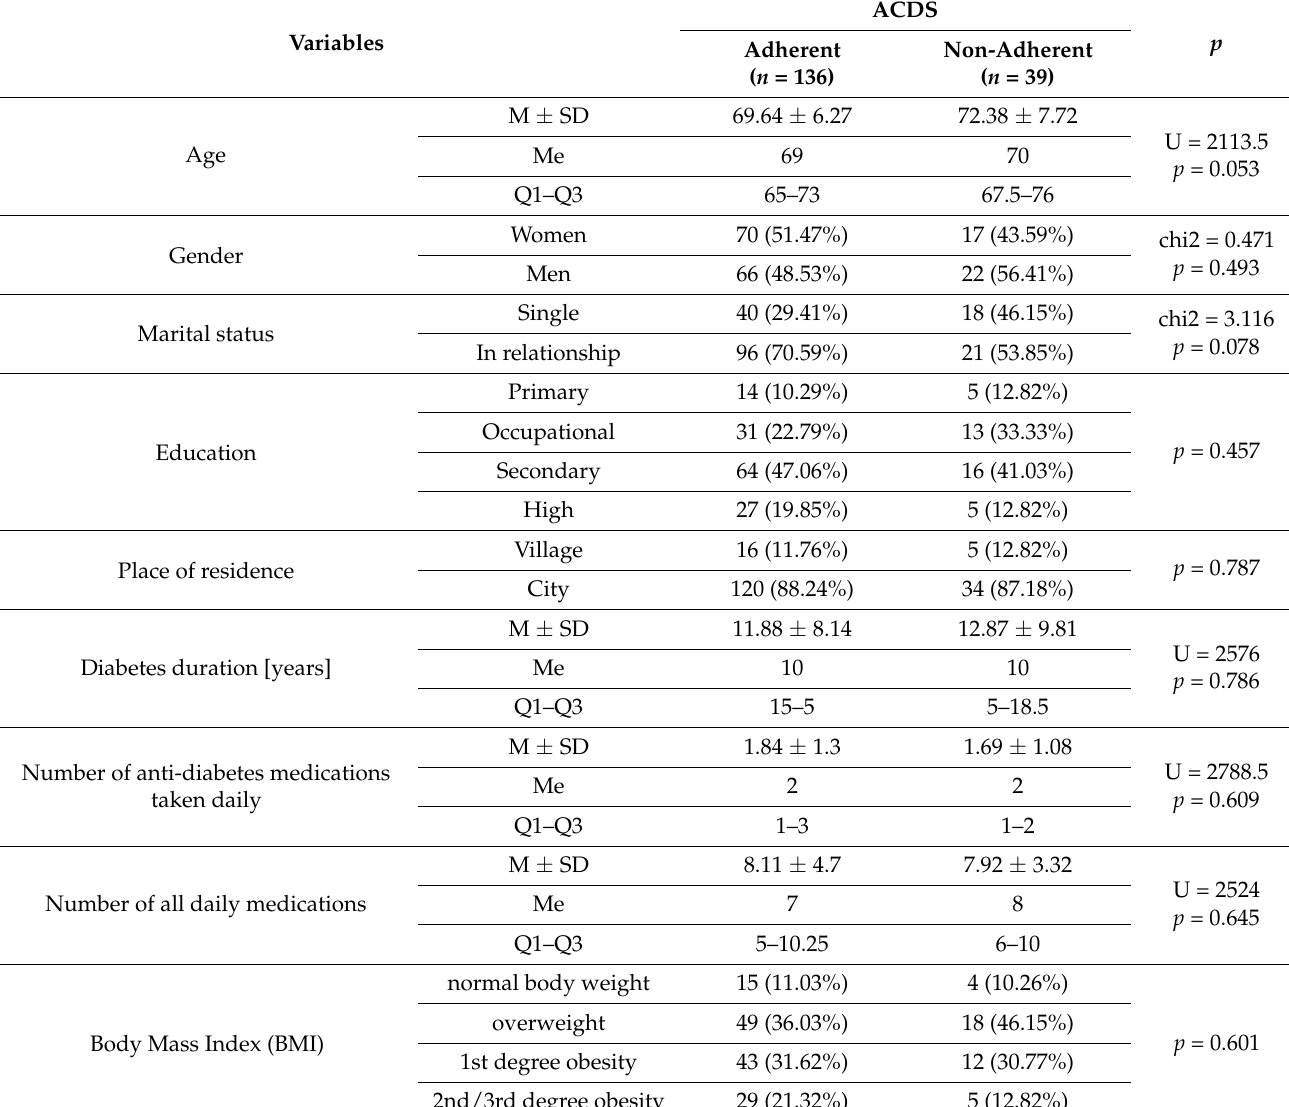
Table 4. Socio-demographic and clinical variables in adherent and non-adherent